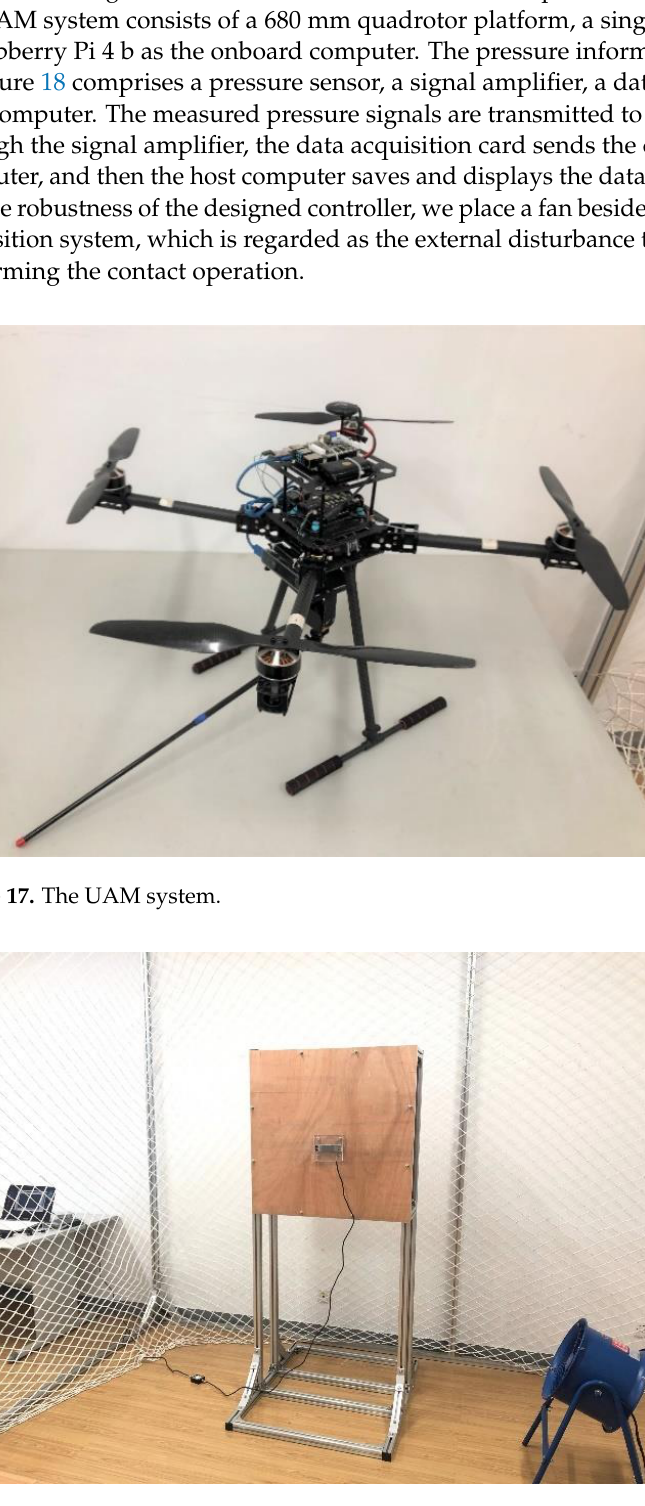
Figure 16. Contact force generated by the aerial manipulation.